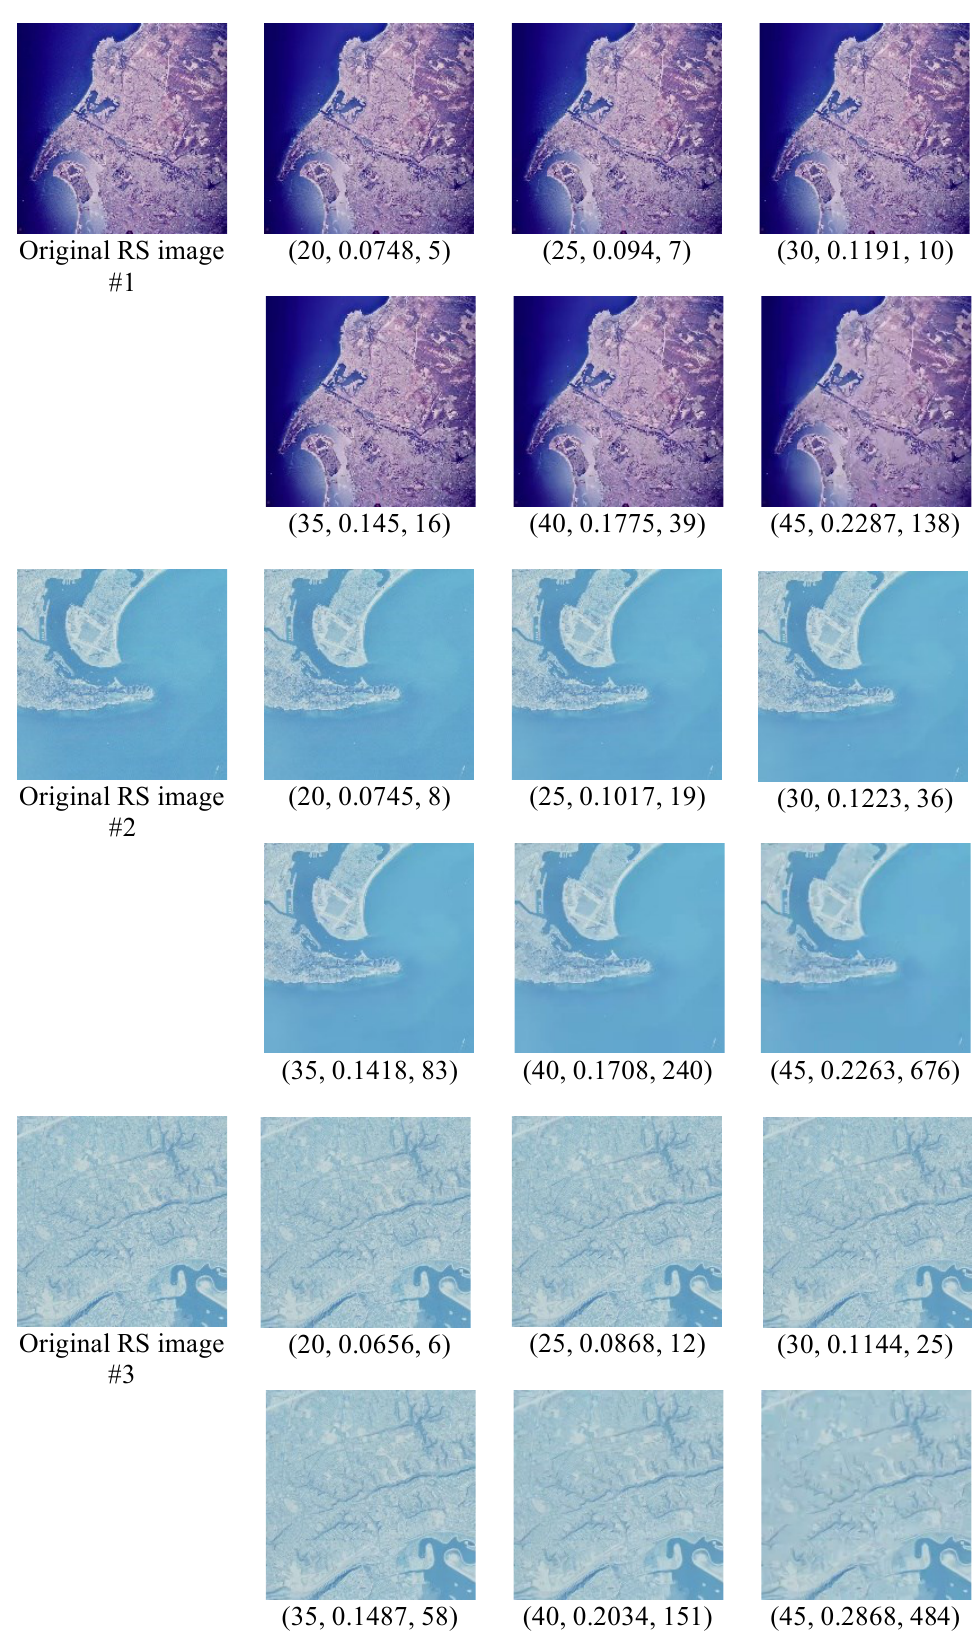
Figure 2. Samples of the basic RS images used in experiments. The values provided in brackets concern Q , MDSI, and CR values,